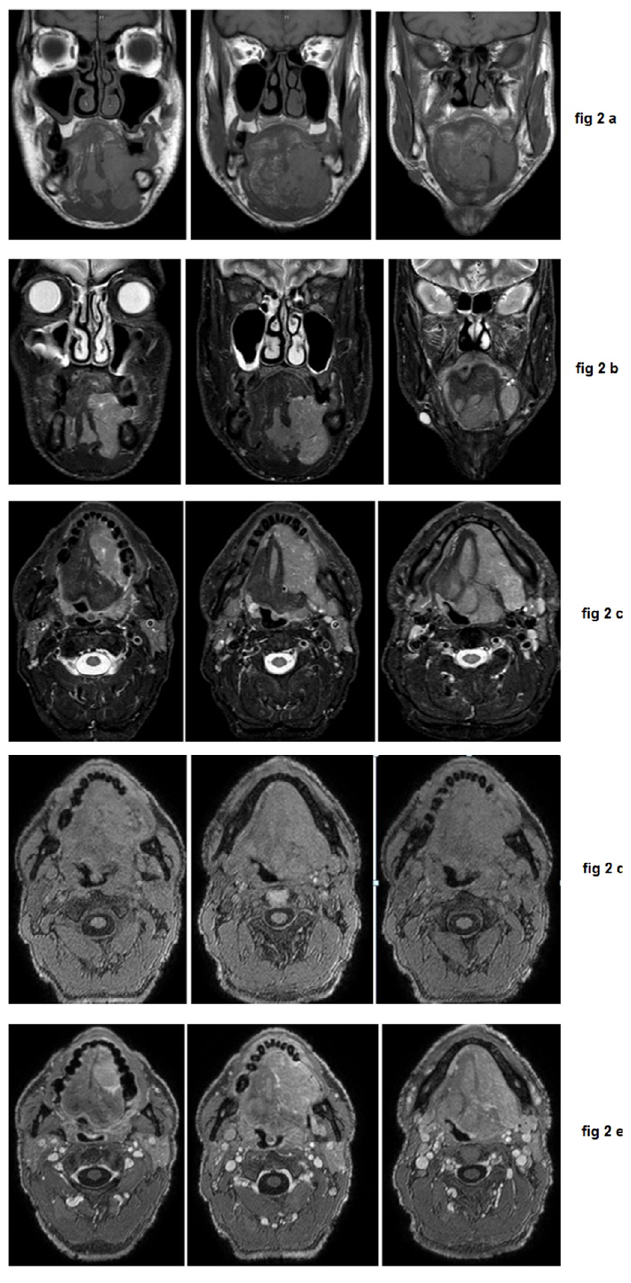
signal; (b) coronal T2WI high signal; (c) axial T2WI high signal; (d) axial STIR (short tau inversion recovery) fat suppression MRI high signal; (e) T1 with contrast homogenous